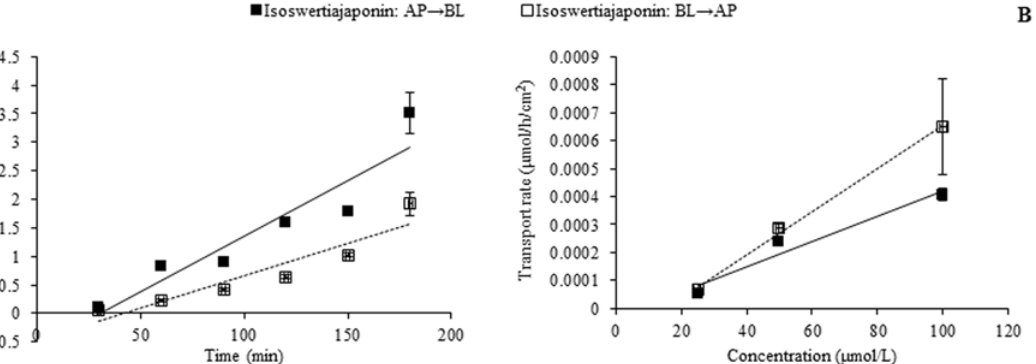
Fig 4. Transport of isoswertiajaponin across Caco-2 cell monolayer. Notes: (A) The percent transport of isoswertiajaponin as a function of time at 50 μ mol/L; (B) The transport rate of isoswertiajaponin as a function of concentration at 90 min.